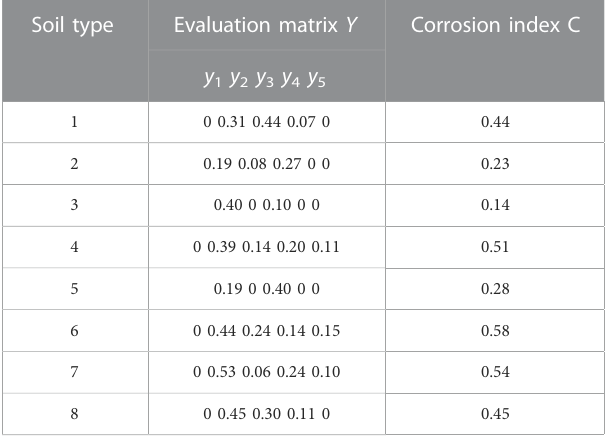
TABLE 5 Range of average residual life ARL of grounding electrodes for three soil